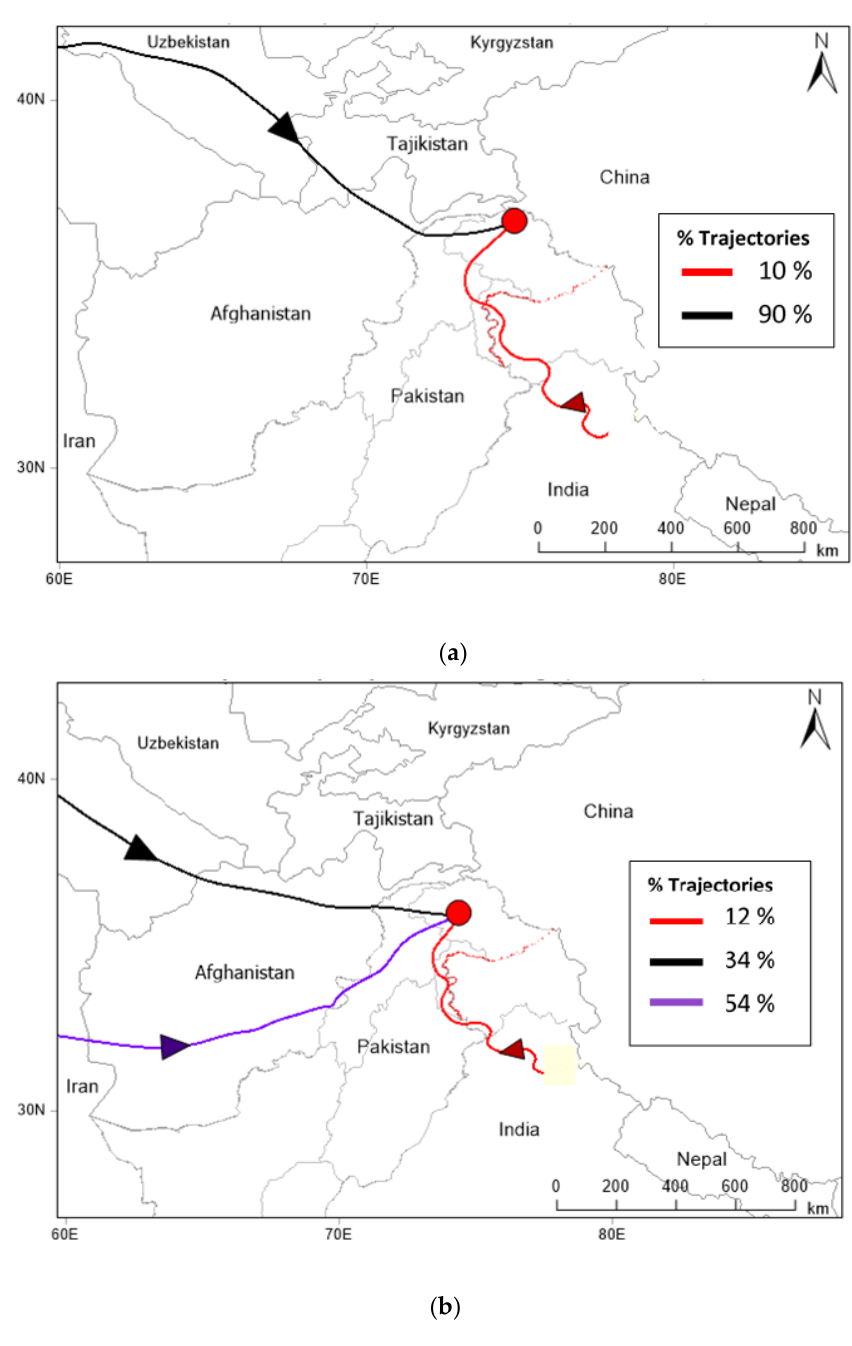
Figure 9. ( a ). Percentage of five-day back air trajectory clusters reached over Sost during winter, 2019. ( b ). Average percentage of five-day back air trajectory clusters reached over Hunza, Gilgit, Jaglot and Chilas during winter, 2019.